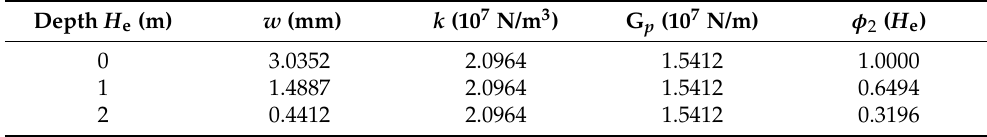
Table 5. Results for a beam embedded in a transversely isotropic foundation ( E T 22 = 57.6 MPa). Depth H e